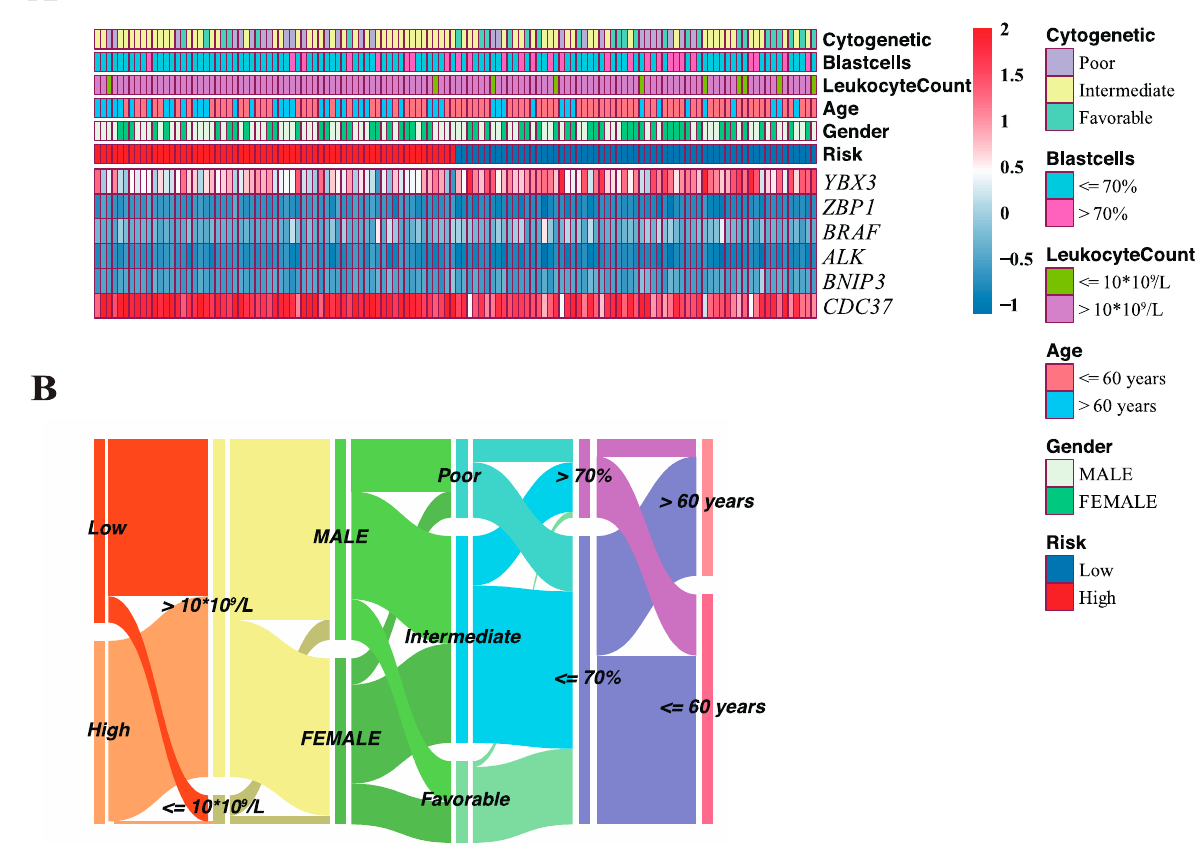
Figure 5. Characteristics of classical clinical features in two risk subgroups. ( A ) Heatmap visualizing the expression of 6 genes and clinicopathological features at different risk levels in TCGA cohort. ( B ) Alluvial diagram demonstrating a dynamic network of the interrelated clinical features in TCGA cohort.